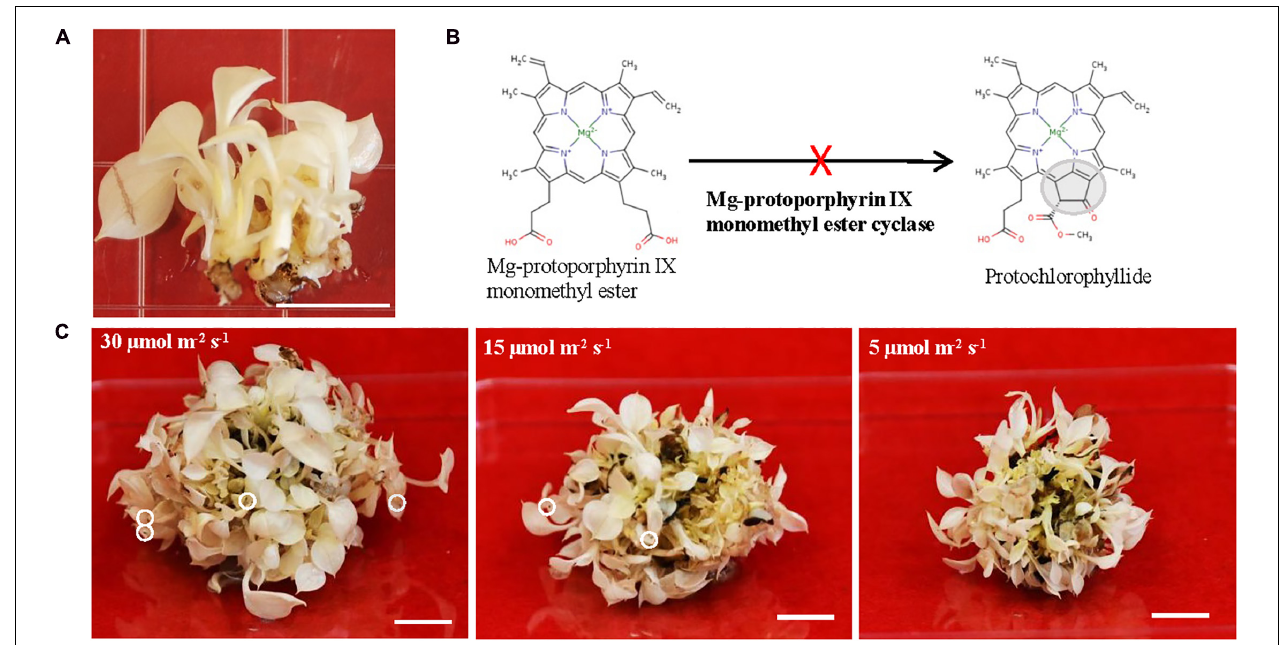
FIGURE 1 | The growth of albino plants and the involvement of EaZIP . (A) Albino plantlets. (B) Impaired EaZIP in chlorophyll biosynthesis pathway. (C) Albino plantlets were grown under ∼ 30, 15, and 5 µ mol m − 2 s − 1 light intensity at 23 ◦ C for 4 weeks. The white circle indicates damaged leaf-tip. Bar = 1 cm.